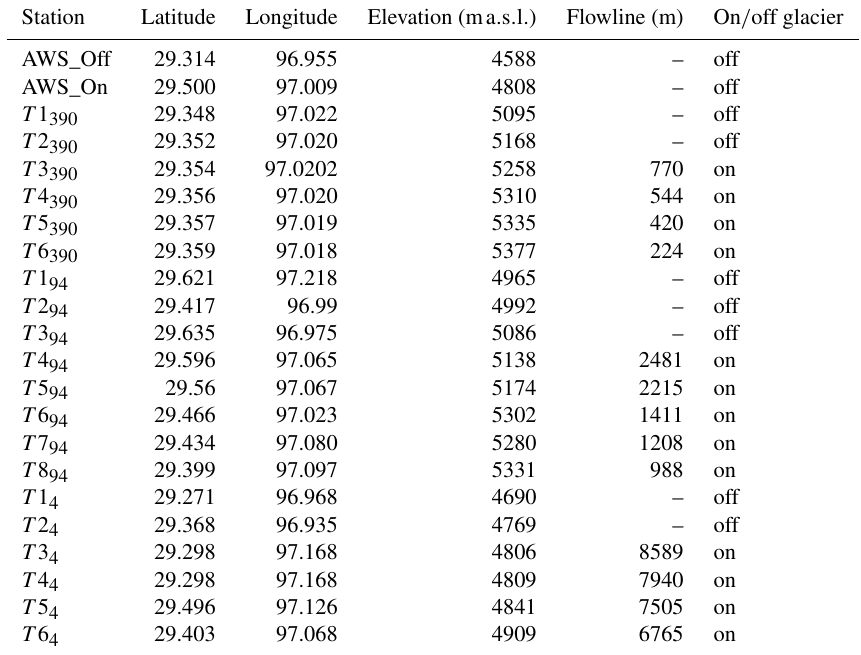
Table 1. Details of each AWS/ T -logger station used in this analysis including the calculated flowline distances. Station Latitude Longitude Elevation (ma . s . l .